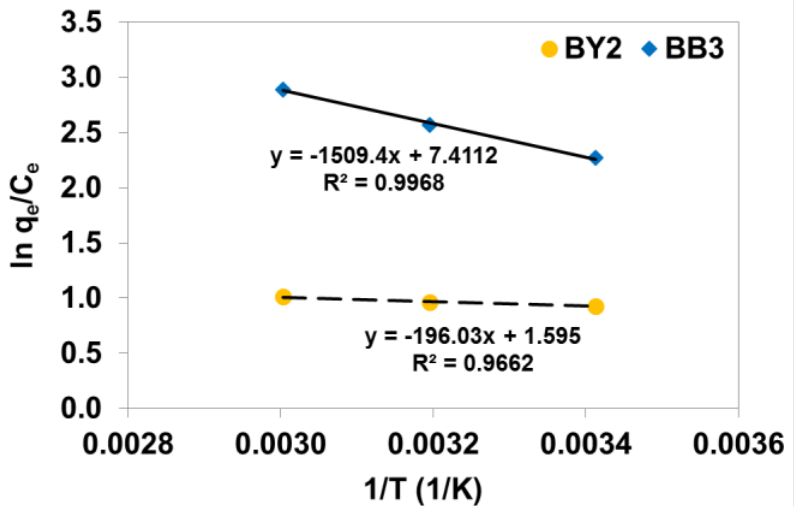
Figure 5. The van’t Hoff plot for calculation of enthalpy and entropy in BB3–C/SiO 2 and BY2–C/ SiO 2